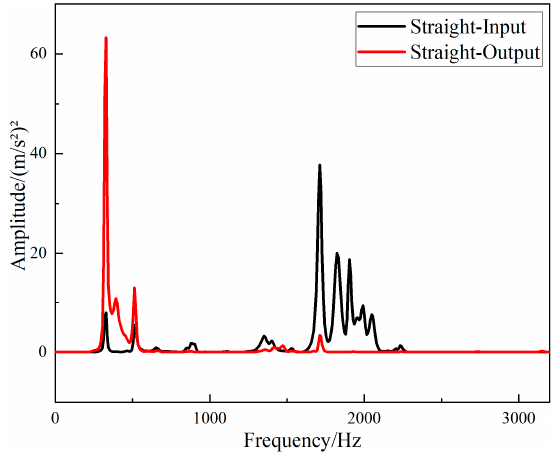
Figure 16. Frequency domain input and output signal of the straight-tube structure support.